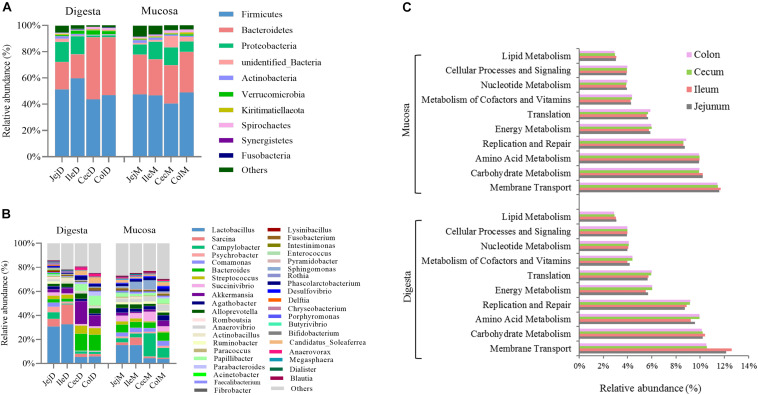
Overview of the intestinal microbial composition and potential functions. Community composition in the digesta- and mucosa-associated microbiota at different intestinal locations at the phylum (A) and genus (B) levels. (C) The top 10 dominant KEGG pathways (expect for poorly characterized bacteria) in both the digesta- and mucosa-associated microbiota at different intestinal locations.